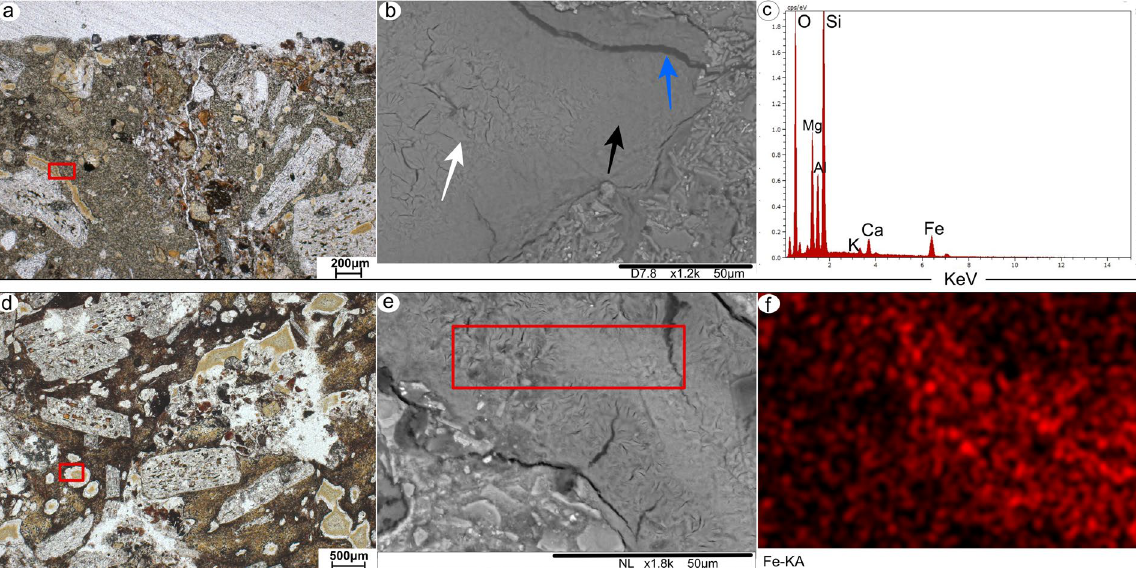
Figure 4. Petrographic and SEM images of selected alterations. ( a ) P1-Bwb3, 34–45 cm: brown infilling in a rock fragment (red rectangle). ( b ) the same infilling analysed with SEM. Note the abundant cracks in the centre of the infilling (white arrow) with smoother boundaries (black arrow) and a large crack next to the contact with the rock (blue arrow). ( c ) EDS spectrum of the infilling. ( d ) P2-Bwb1, 20–30 cm: brown infilling with a white rim in a rock fragment. ( e ) the same infilling analysed with SEM. Red rectangle indicate the selected area for elemental mapping ( f ) mapping of Fe in the infilling. Blackish areas indicate a lower Fe content, whereas red colours indicate a higher Fe